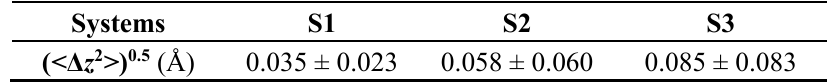
Table 5. The square root of the second moment of the out of plane graphene motion averaged over all the atoms of the cross line for S1, S2 and S3